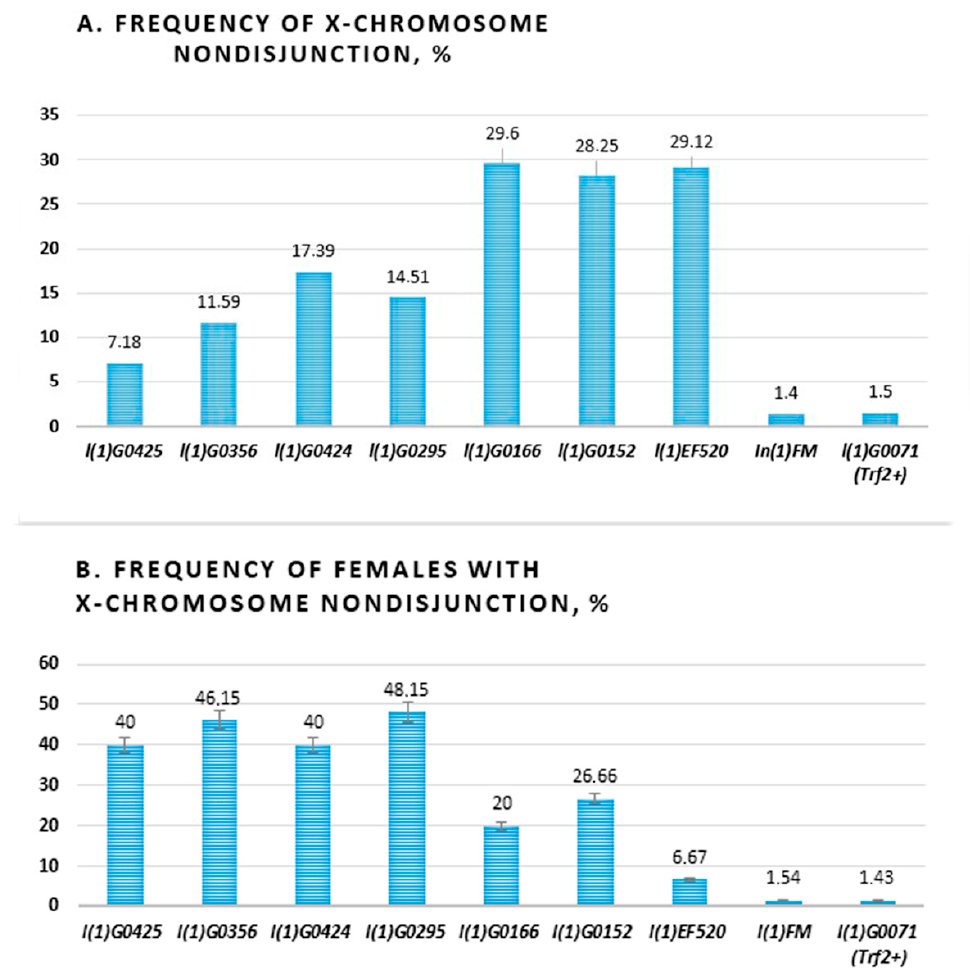
Figure 3. Levels of X chromosome nondisjunction in females with different Trf2 lethal mutations. ( A ) Levels of X chromosome nondisjunction. ( B ) The frequency of females with X chromosome nondisjunction. Below are alleles of Trf2 : ( l(1)G0425, l(1)G0356, l(1)G0424, l(1)G0295, l(1)G0166, l(1)G0152, l(1)EF520 ), and two controls: balancer In(1)FM and l(1)G0071 with wild type Trf2 allele.